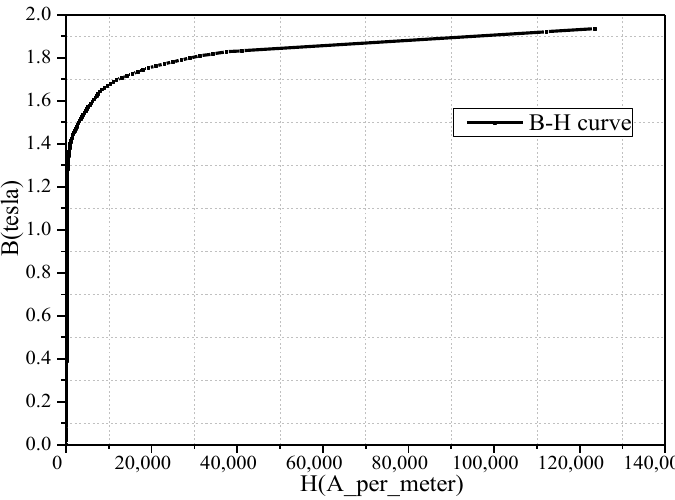
Figure 3. The B - H curve of the lamination